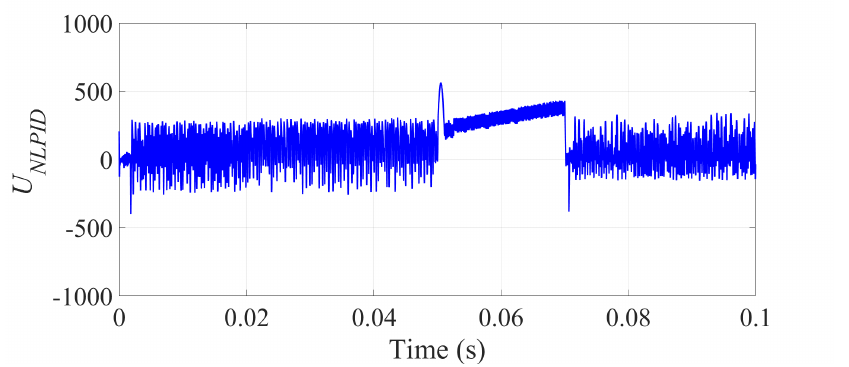
Figure 11. Scenario 1: Control input to generate the duty cycle of a PWM signal using the proposed nonlinear PID controller.